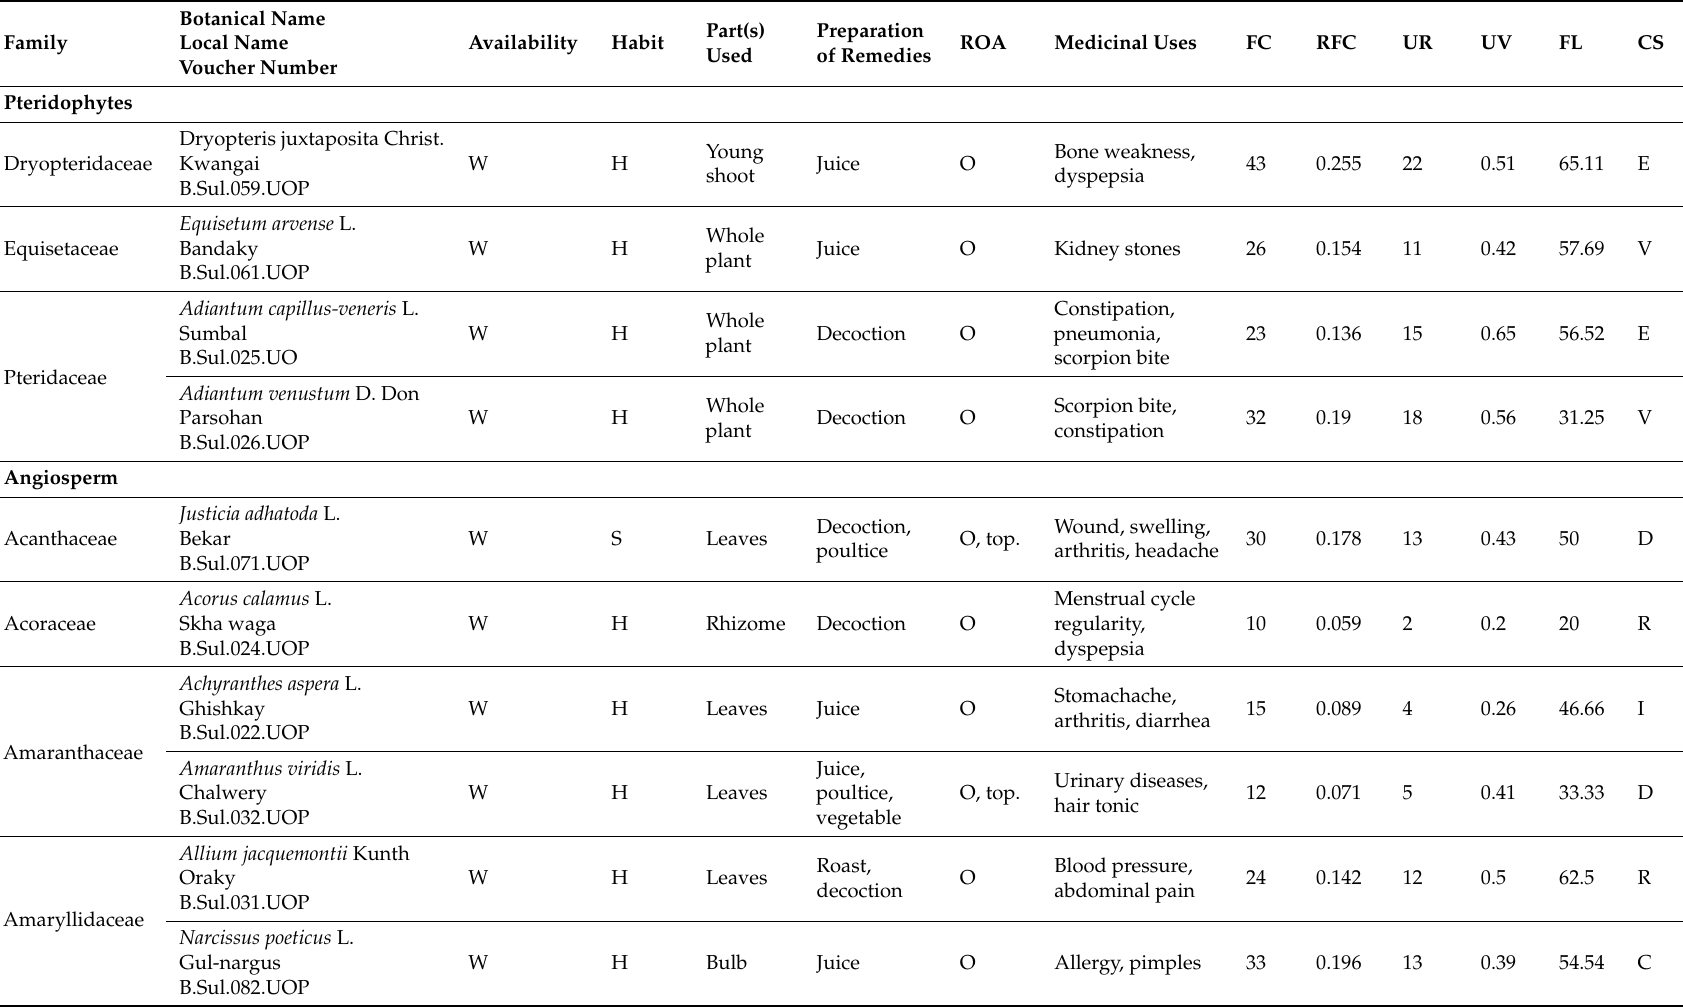
Table 3. Medicinal plant species and fungi in Gokand Valley, Buner, Khyber Pakhtunkhwa,